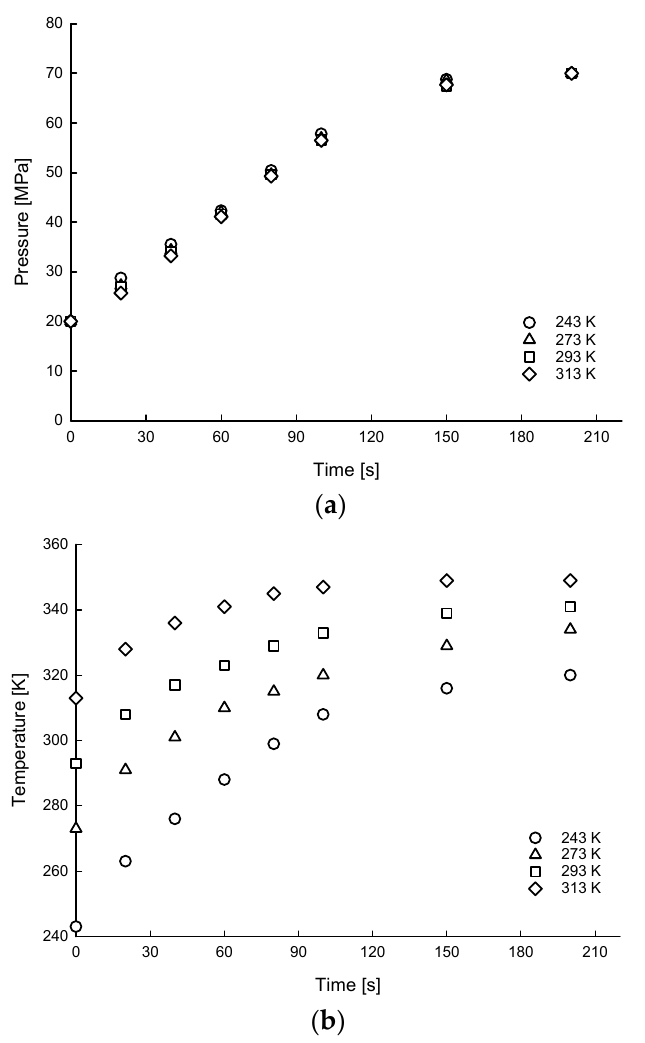
Figure 6. Time histories of hydrogen of average gas pressure ( a ) and temperature ( b ) distributions of filling process for 10 MPa SOC pressure condition under different ambient temperature condi- tions.